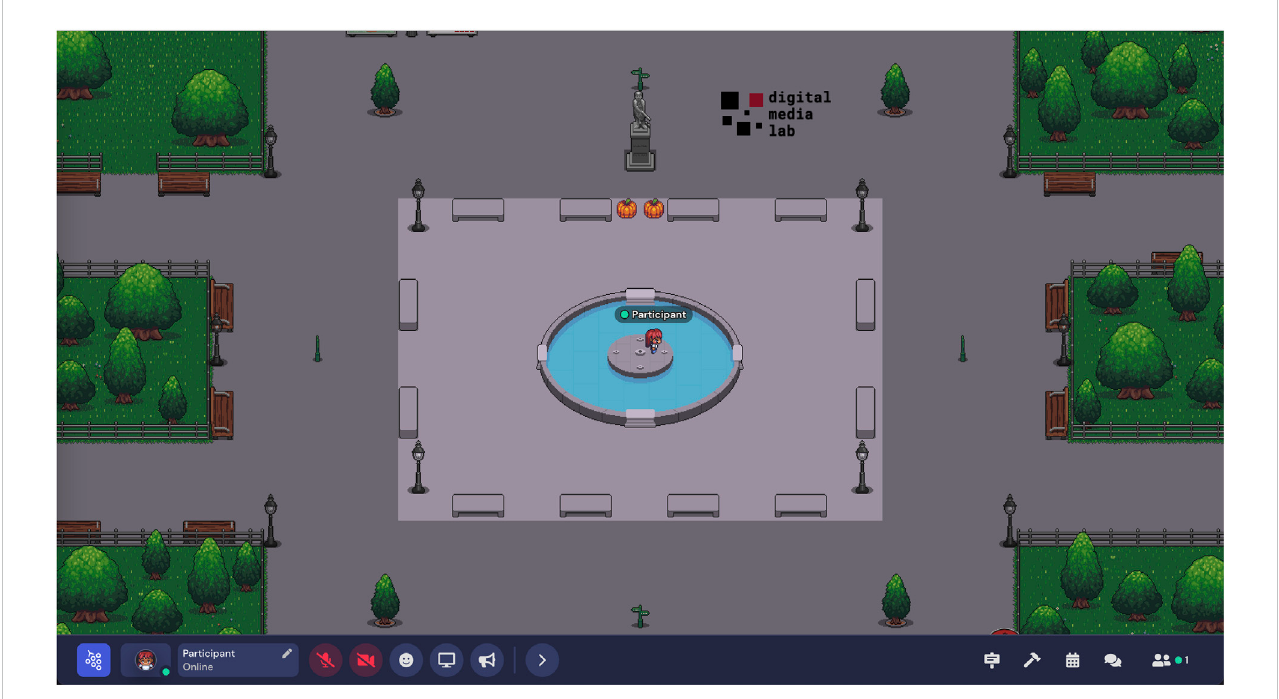
FIGURE 4 Thisshowsthesetupofthe GatherTown platform.Thescenerywasanoutdoorplaceinapark withoutadedicatedpresentationscreen.Thelightergrey space identi fi es one coherent meeting